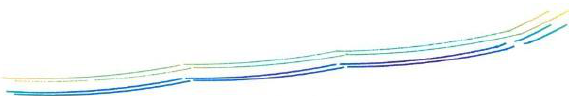
Figure 12. Power line points extraction results when v f = 8 .